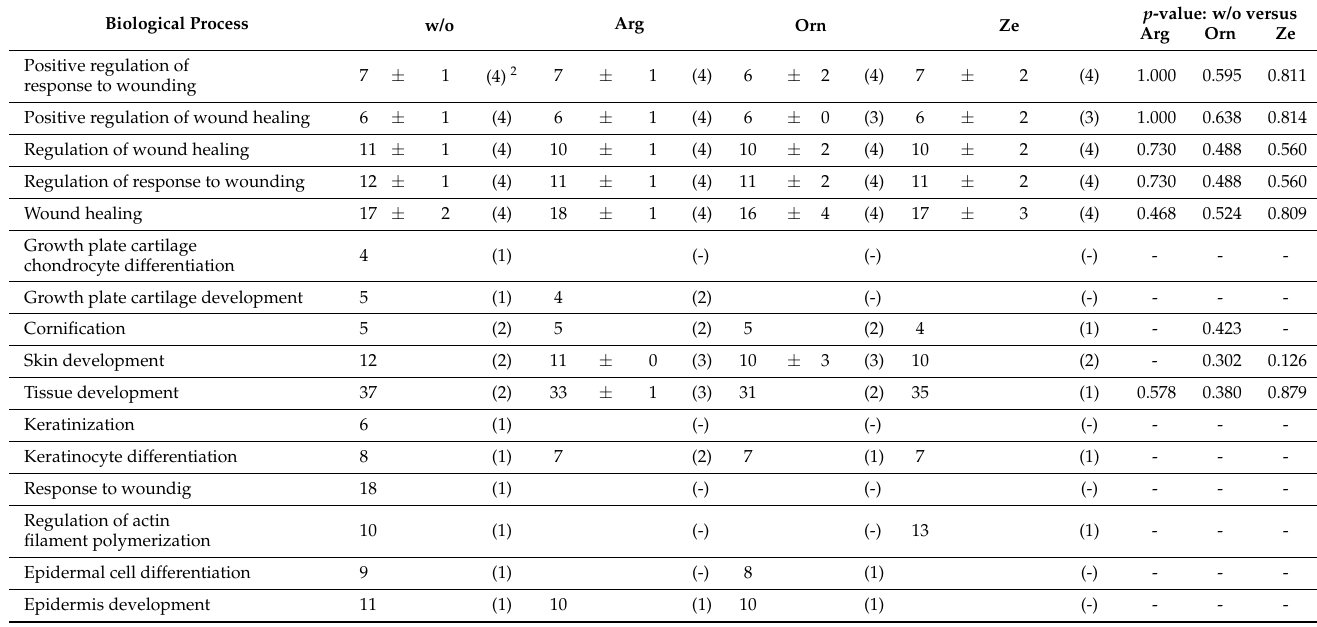
Table 4. Urinary proteins associated with biological processes 1 related to tissue/organ development, cell structure and wound healing, detected in the urine of cats ( n = 4) fed a high-protein diet without (w/o) or with the supplementation of arginine (Arg), ornithine (Orn) or zeolite (Ze). Mean number of proteins ± standard